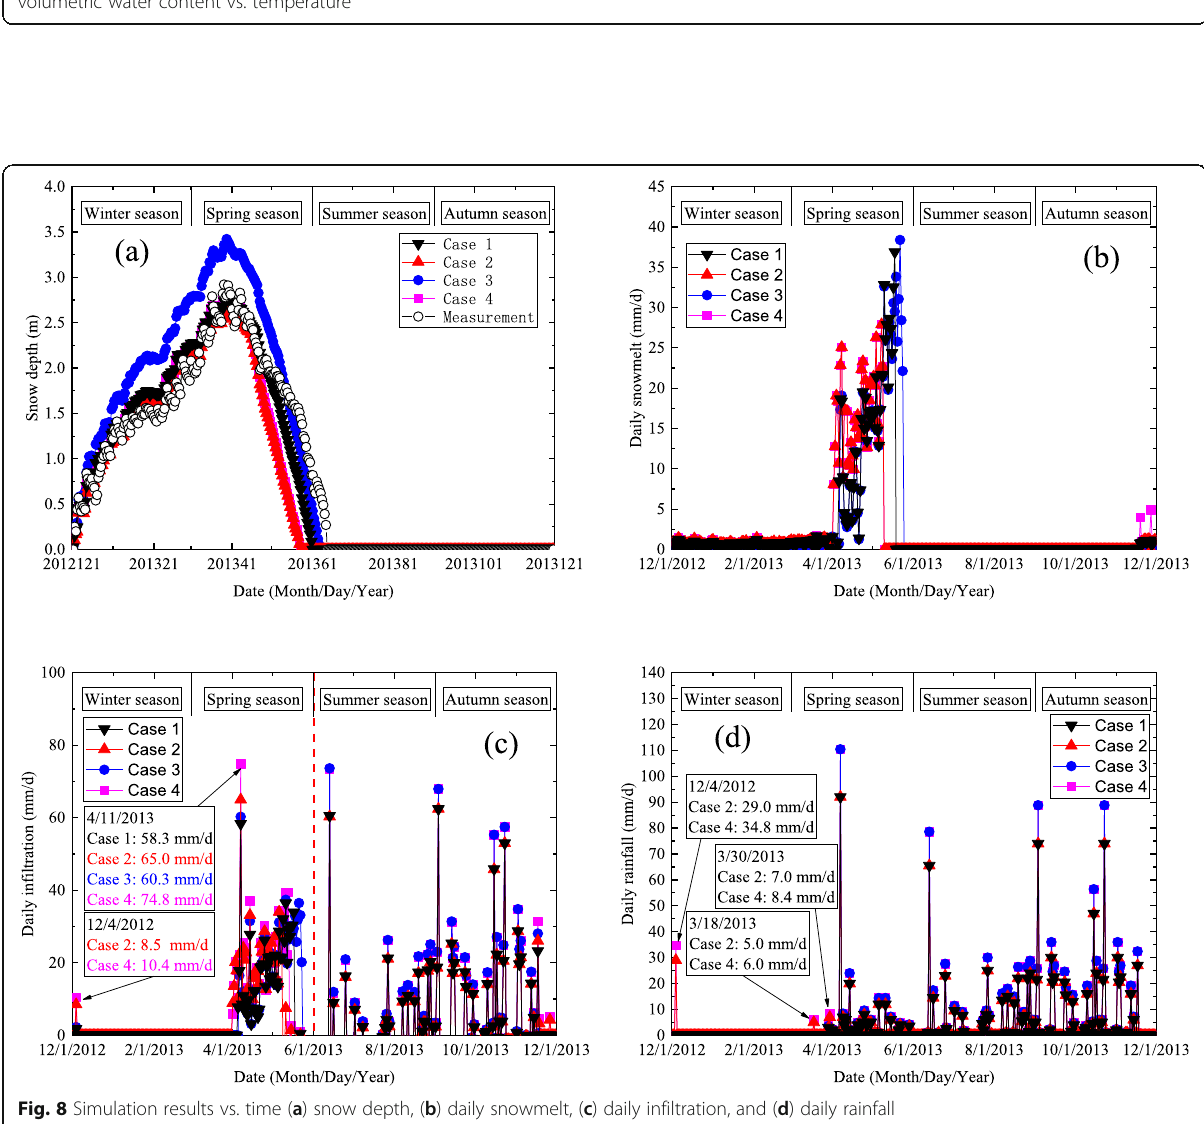
Fig. 8 Simulation results vs. time ( a ) snow depth, ( b ) daily snowmelt, ( c ) daily infiltration, and ( d ) daily rainfall